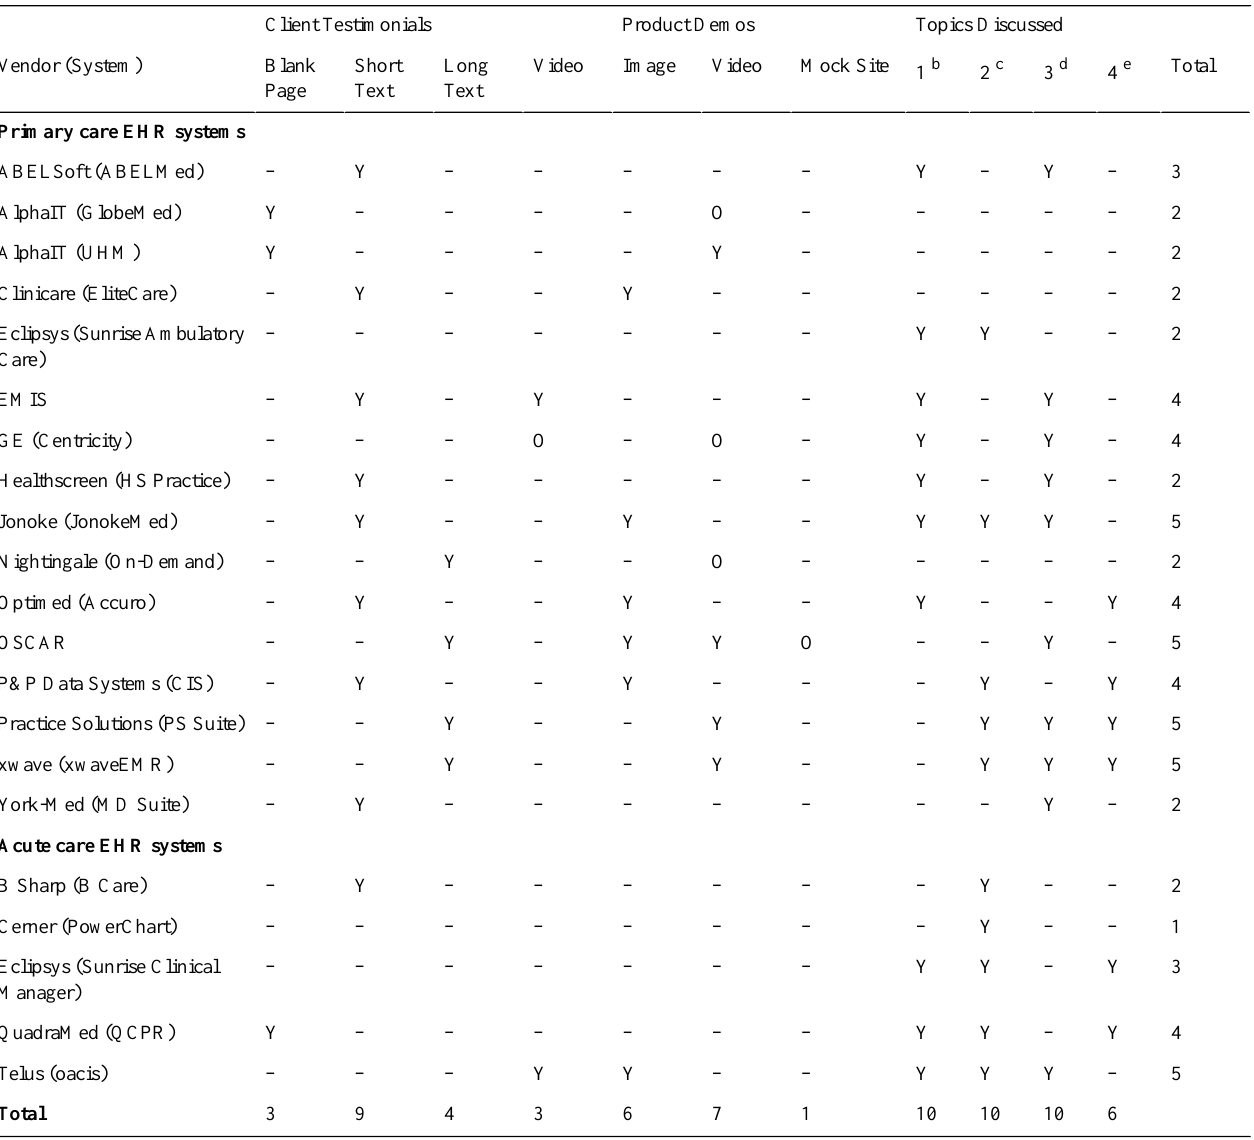
Table 4. Direct persuasive strategies employed on vendor websites a .